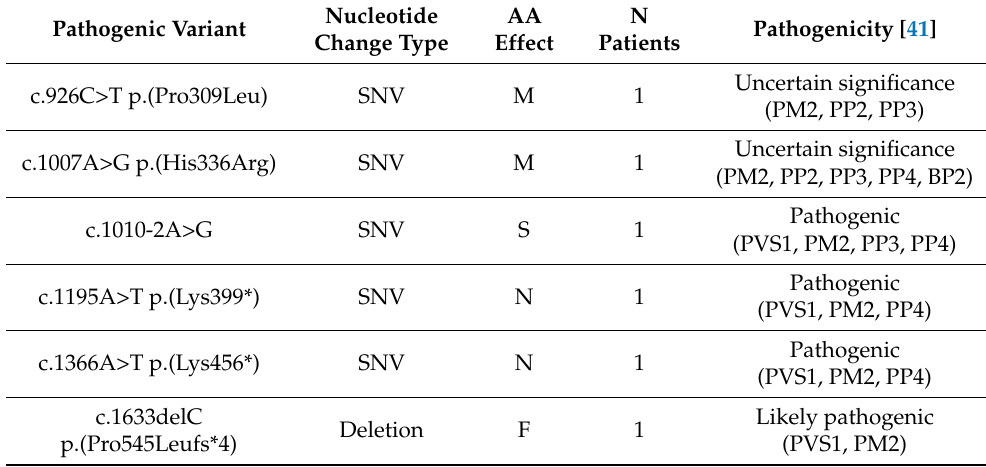
Table 2. Previously undescribed variants in the F8 gene. SNV—single nucleotide variant; M—missense; S—splicing; N—nonsense;